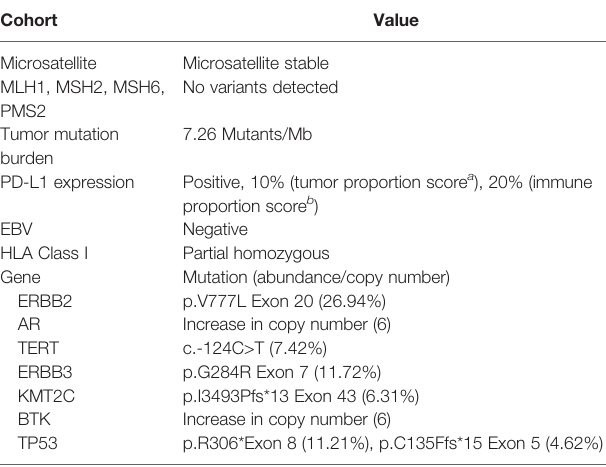
TABLE 1 | The results of next-generation sequencing (NGS)